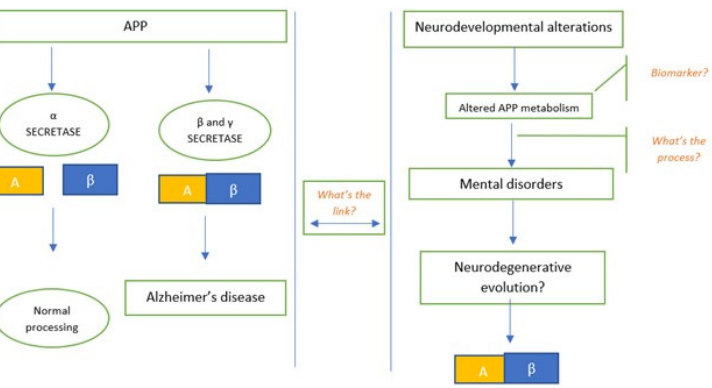
Figure 2. Altered APP pathways in mental disorders could intersect with the neurodegeneration processes of dementia, without sharing the same trajectories. The figure explains the need for a link between the neurodegenerative evolution of APP in the genesis of AD, and the still unknown process behind mental disorders.